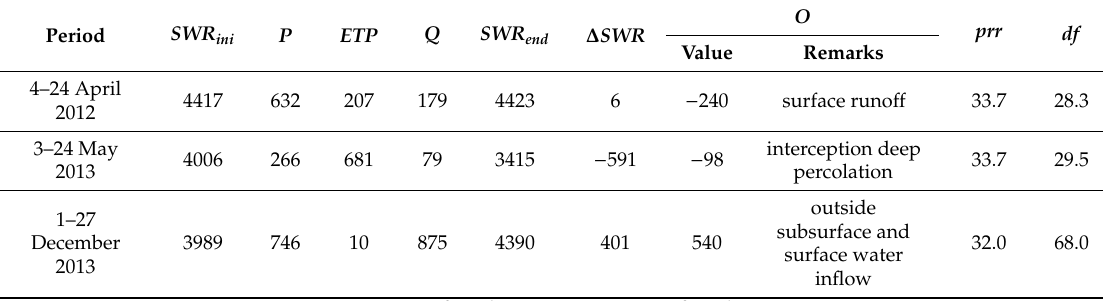
Figure 8. Changes in soil moisture content during the periods 1–5 December ( a ) and 5–27 December ( b ). Table 1. Elements of the water balance in the drainage system catchment scale during the periods under